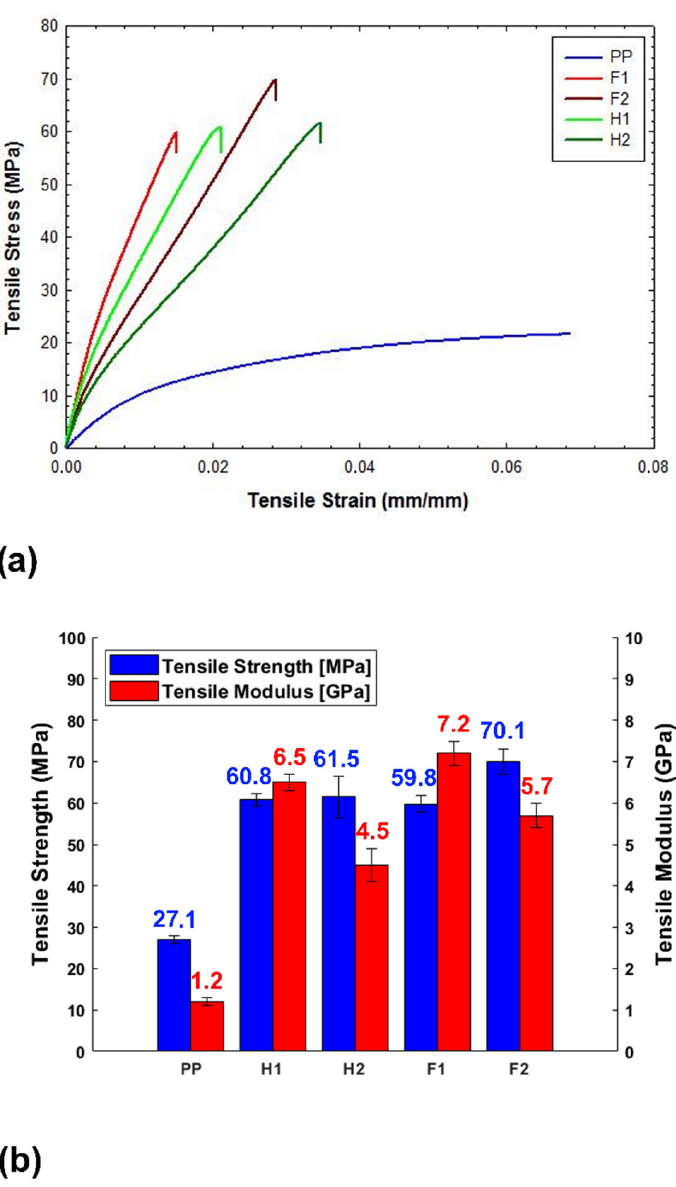
Figure 3. ( a ) Typical tensile stress–strain curves carried out from tensile tests for each sample type and ( b ) mean values of tensile strength and modulus. Table 2. p ‐ values carried out from one ‐ way ANOVA test on the results of tensile, bending and impact tests. Method: null hypothesis; significance level: α = 0.05. σ ts : tensile strength; E t : tensile modulus; σ fs : flexural strength; E f : flexural modulus; U: specific adsorbed energy.